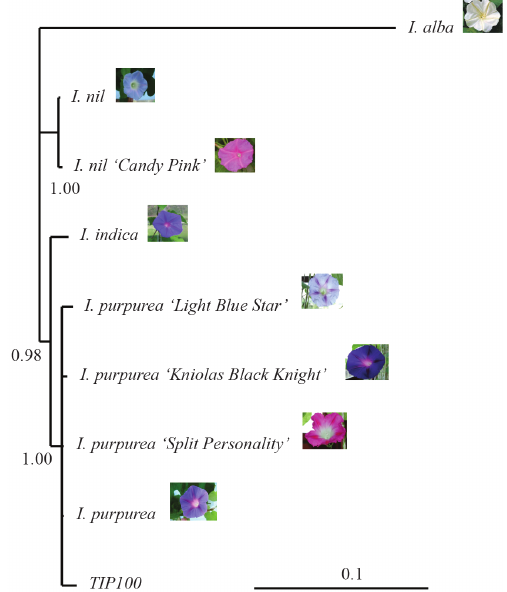
Figure 1 - Unrooted phylogenetic tree of Tip100 transposons, with pic- tures of the respective flowers, as defined through Bayesian analysis. The evolutionarymodelusedwasHKY,asdeterminedbytheAkaikecriterion. The numbers on the branches correspond to posterior probabilities esti- mated from the Bayesian analysis.